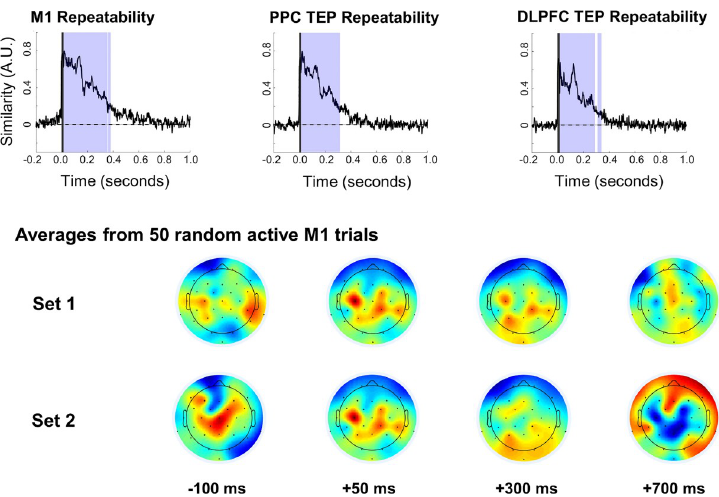
Fig 5. Top: Group-level within-condition repeatability curves comparing within-participant and within-condition averages for active stimulation. The y-axis indicates arbitrary similarity units with a possible range of -1 to +1. Light Shading shows periods of significant difference from pre-stimulation baseline. The dark shaded regions from -1 ms to 15 ms indicate TMS pulse interpolation. Bottom: Plots show topographical distributions of two averages from active M1 stimulation, constructed using 50 non-overlapping trials each from one